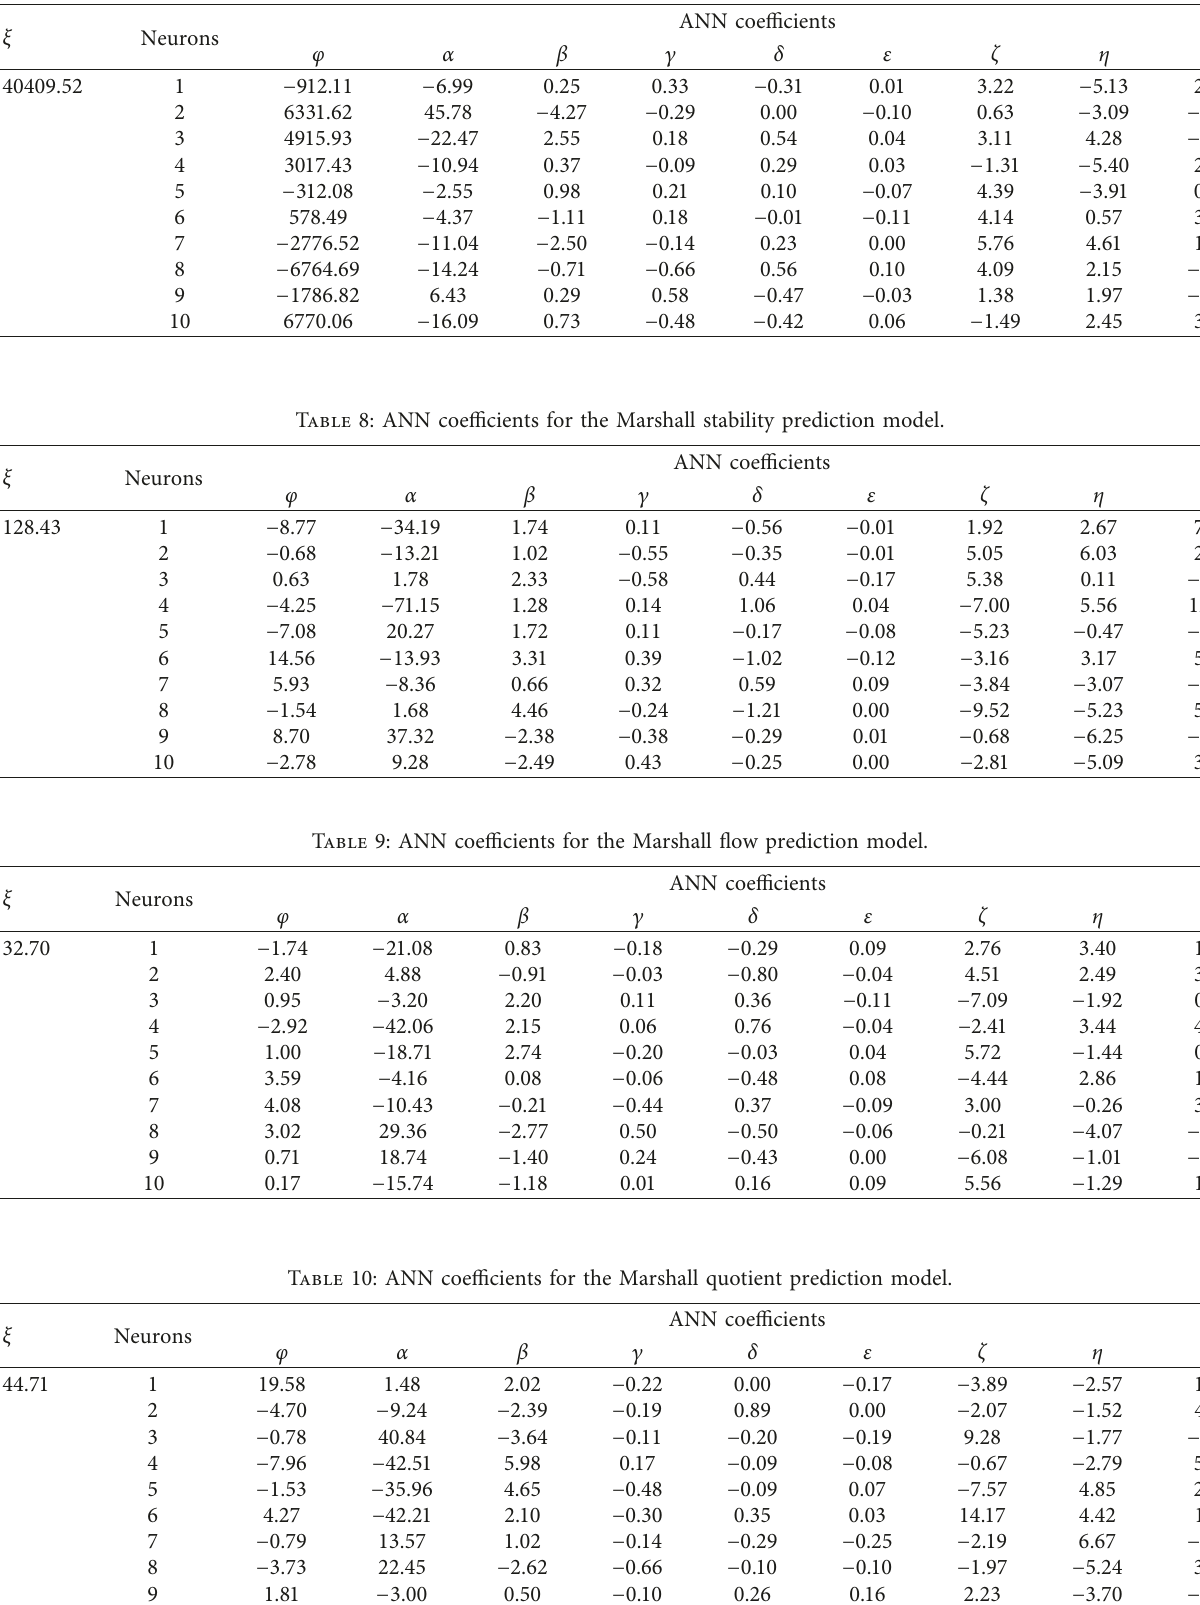
Table 7: ANN coefficients for the stiffness modulus prediction model.